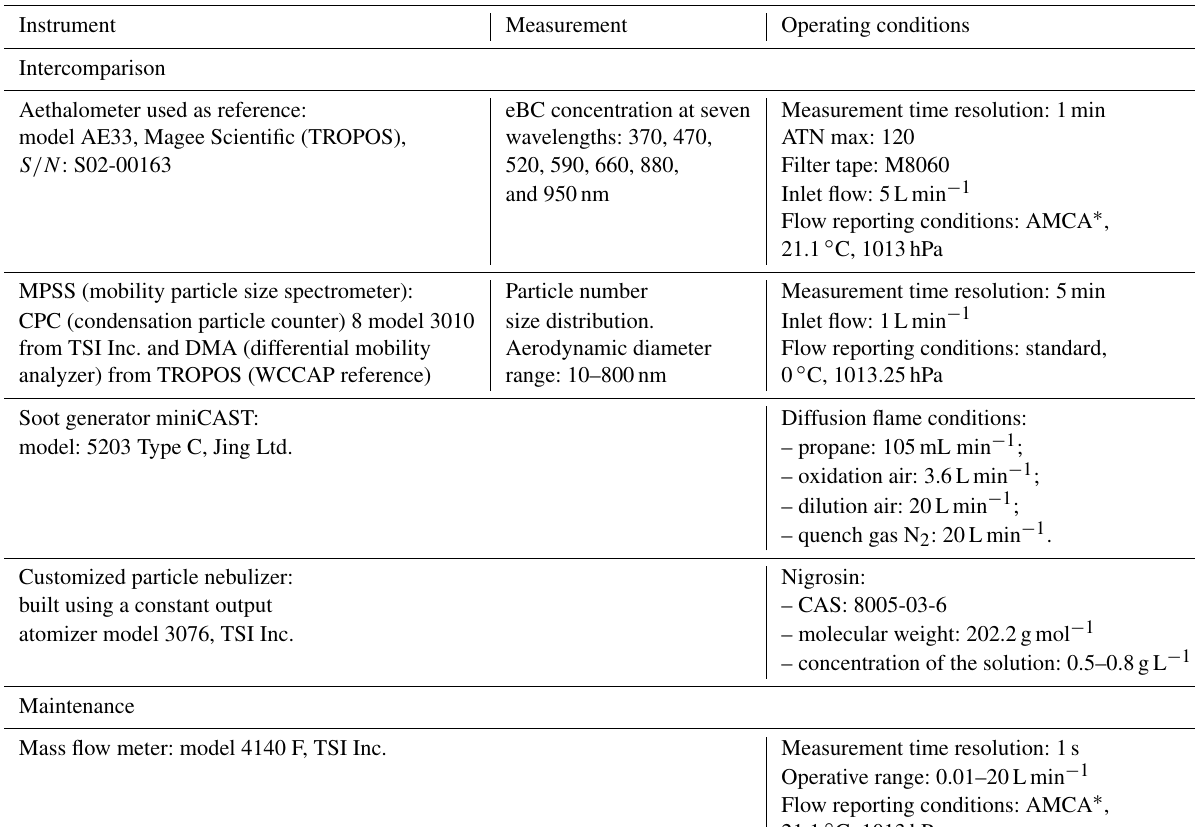
Figure 2. The intercomparison procedure. Table 2. Instruments employed during the